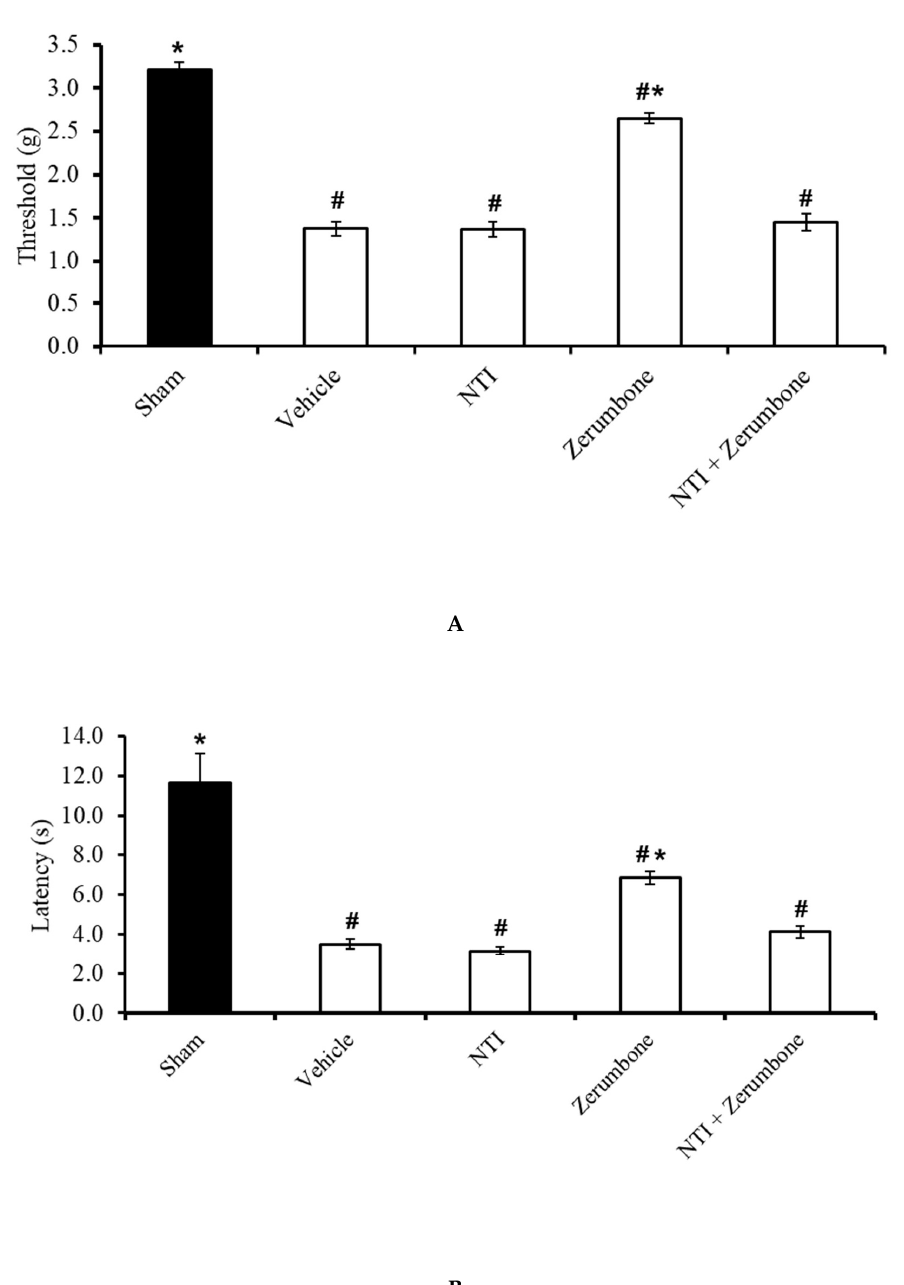
Figure 7. Effect of zerumbone (10 mg/kg; i.p.) and pre-treatment with a selective δ-opioid receptor antagonist (naltrindole, NTI; 20 mg/kg; s.c.) on the responses toward ( A ) mechanical allodynia and ( B ) thermal hyperalgesia on CCI-induced neuropathic pain in mice. Each column represents the mean ± SEM; n = 8 mice per group. Note: # significantly different ( p ≤ 0.05) than sham group; * significantly different ( p ≤ 0.05) than vehicle group (one-way ANOVA followed by Tukey’s post hoc test).